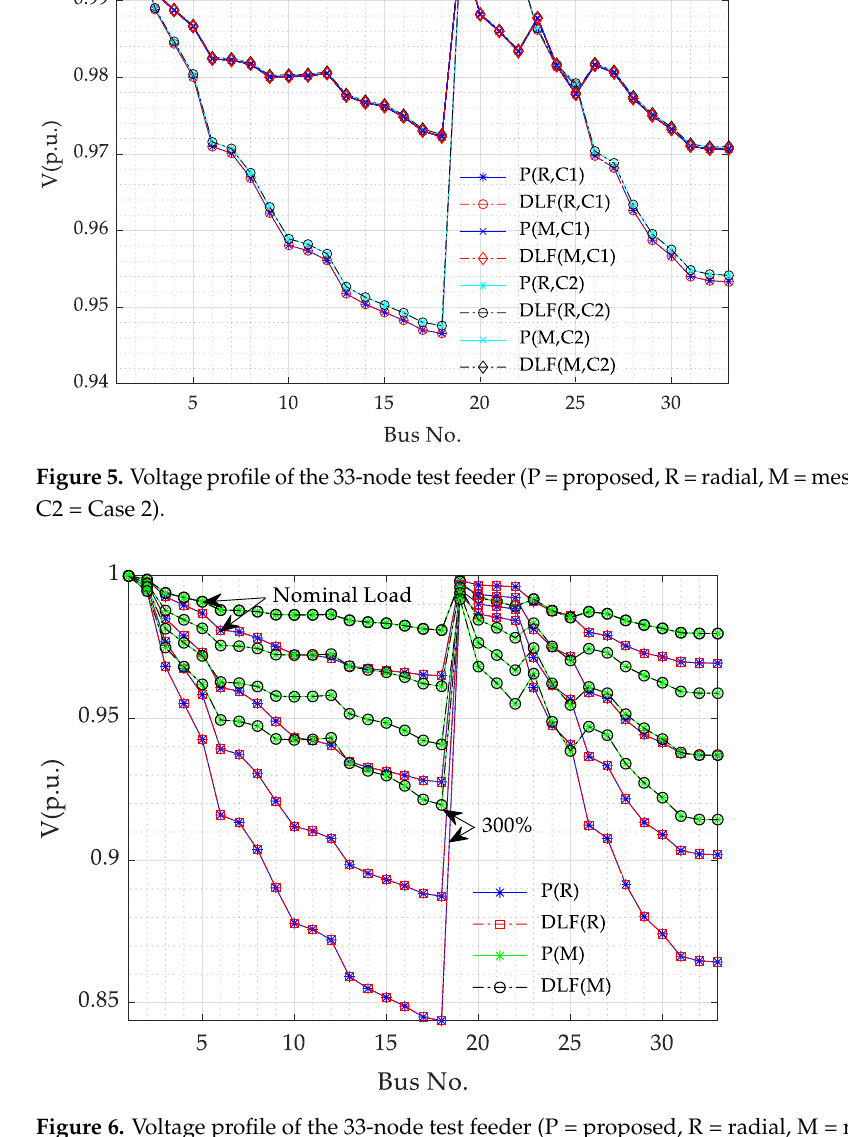
Figure 6. Voltage profile of the 33-node test feeder (P = proposed, R = radial, M = meshed, Case 1).